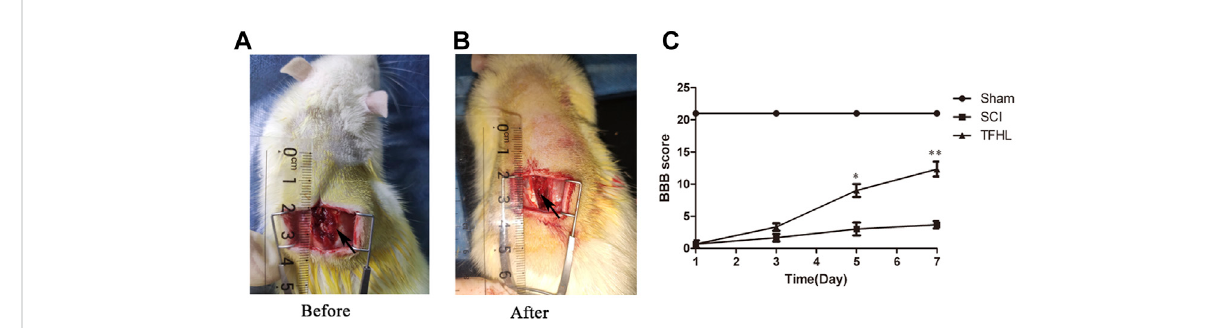
FIGURE 1 TFHLpromotesmotorfunctionrecoveryafterSCI. (A,B) Theexposureofspinalcordtissuebeforeandafterinjuryinrats. (C) BBBscoresofratsin eachgroupat1,3,5,and7 days postSCI.AllratsintheShamgroupexhibitedBBBscores of21 fortheentiremeasurementperiod.TheSCIgrouphad thelowestBBBscores.TheBBBscoresintheTFHLgroupwereconsiderablyhigherthanthoseoftheSCIgroup,inwhichthedifferenceinBBBscores was the most obvious on day 7. All data are expressed as the mean ± SD. Differences among groups were determined with repeated measures ANOVA. n = 15 in each group, * p < 0.05, ** p <